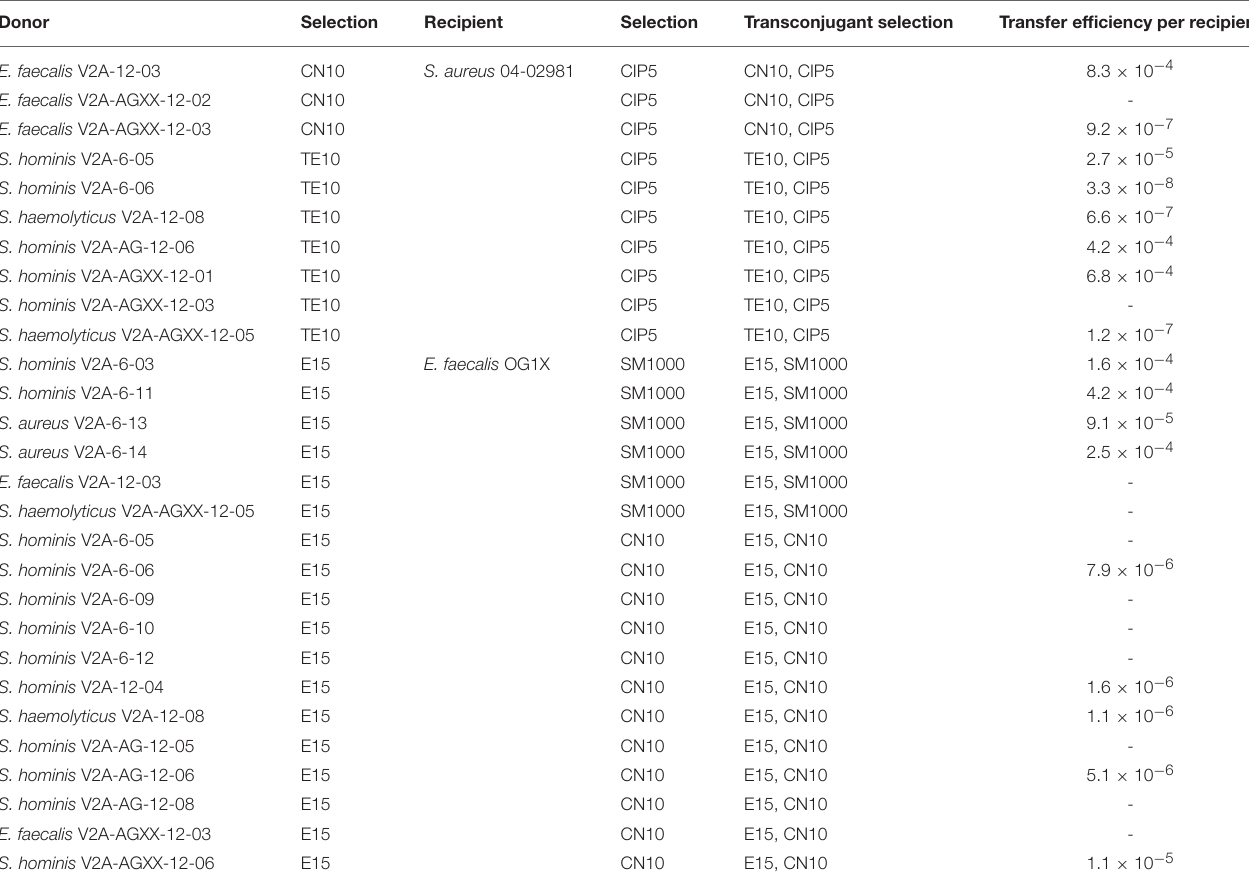
TABLE 4 | Efficiency of gentamicin, erythromycin, and tetracycline resistance transfer from ISS-isolates to S. aureus 04-02981 and E. faecalis OG1X. Donor